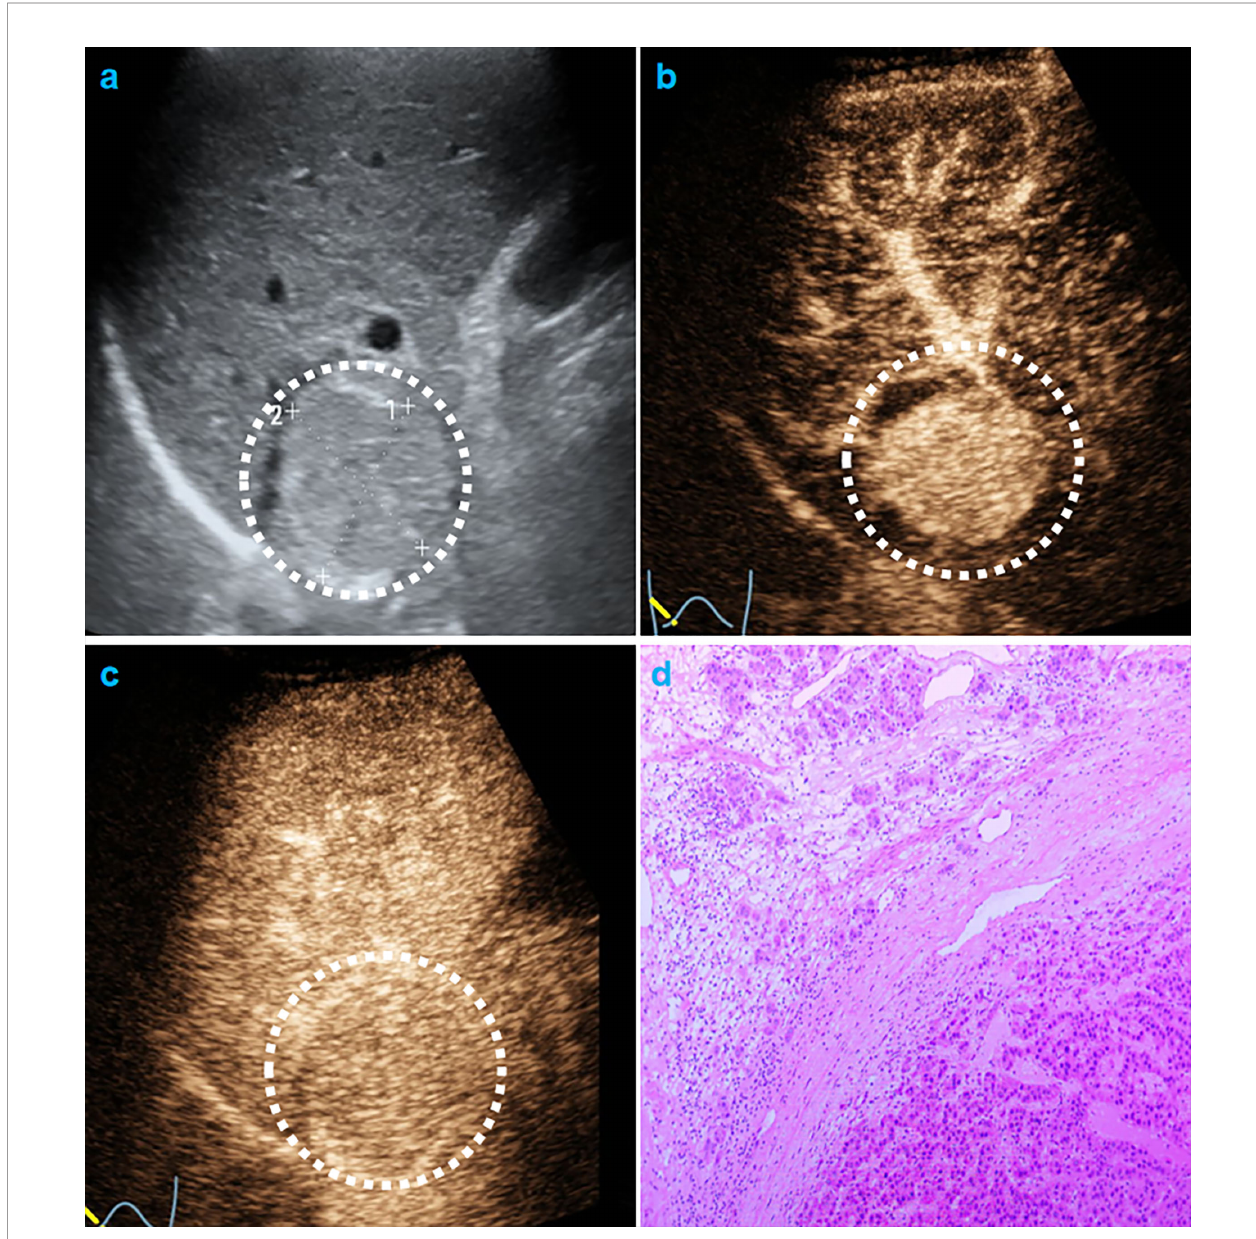
FIGURE 2 | CEUS LR-5 and MVI-negative HCC. Male cirrhotic patient shows a 36.8mm, hypo-echoic HCC (AFP=4.1ng/mL) on US (A) . On CEUS, the HCC shows arterial phase hyper-enhancement (25s, B ) and mild and late washout (80s, C ). The pathological specimen shows well differentiated HCC and absence of MVI (D)